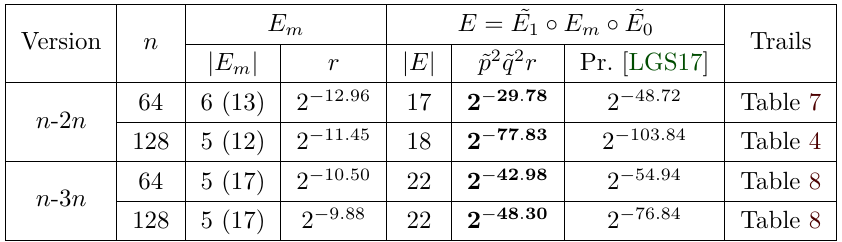
Table 1: Probabilities of the boomerang distinguishers of SKINNY where | E m | denotes the number of rounds E m